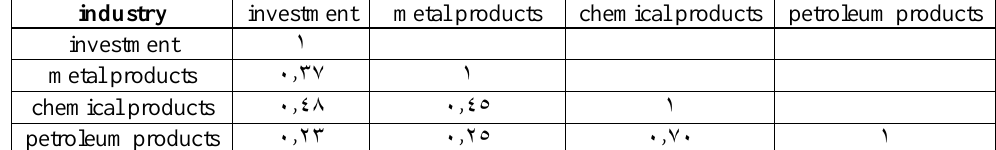
Table 16. Correlation matrix for stock returns of indices in the designated industries industry investment metal products chemical products petroleum products investment 1 metal products 0.08 1 chemical products 0.74 0.71 petroleum products 0.00